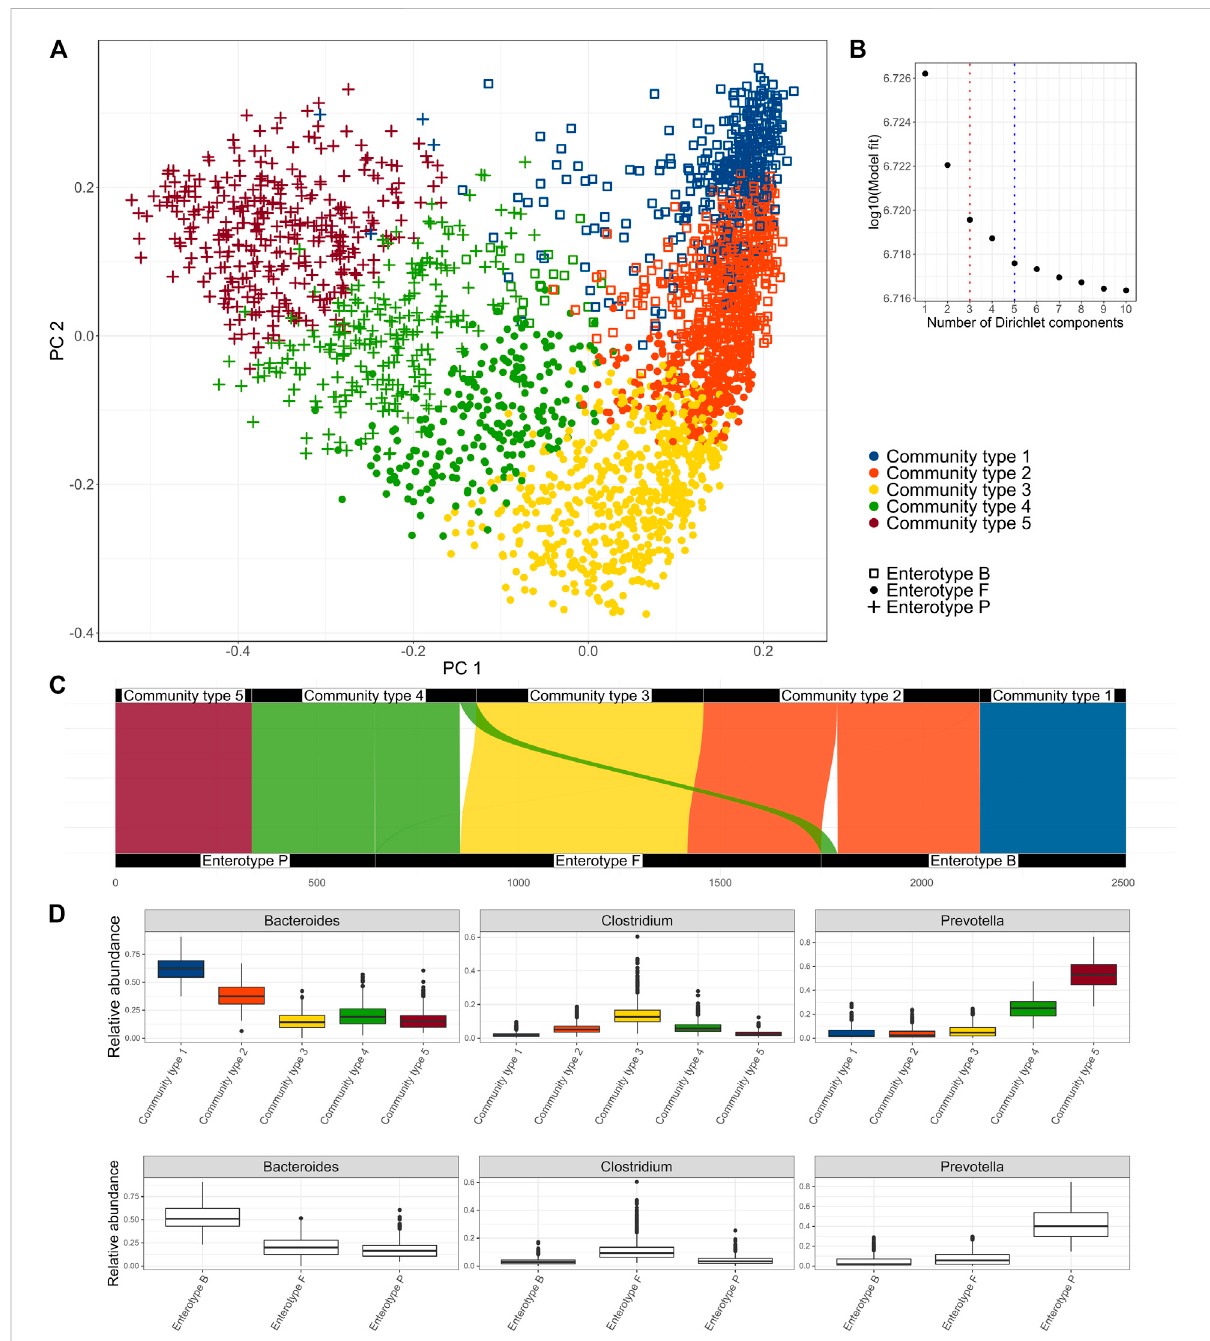
FIGURE 1 Clusters identi fi ed in the Estonian microbiome cohort metagenome data obtained by the Dirichlet Multinomial Mixture Model. (A) enterotypes and community types on the PCoA biplot of the species-level microbiome pro fi le based on the Bray-Curtis dissimilarity, (B) Model fi t by the number of clusters; 3 clusters represent the enterotype (ET) model and 5 clusters were selected as an optimal number (community type CT model), (C) Correspondence of the clusters obtained by the CT model with the clusters obtained by the ET model, (D) relative abundances of the driving genera by the community types and